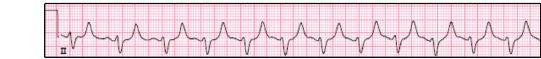
Figure 3: EKG from the patient’s admission showing atrial fibrilla- tion with rapid ventricular response and peaked T